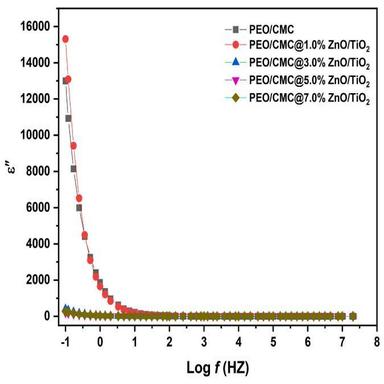
Variation of logarithm frequency with εʹ' of PEO/CMC composite and PEO/CMC filled 1.0, 3.0, 5.0 and 7.0 wt% of ZnO/TiO2 NPs.